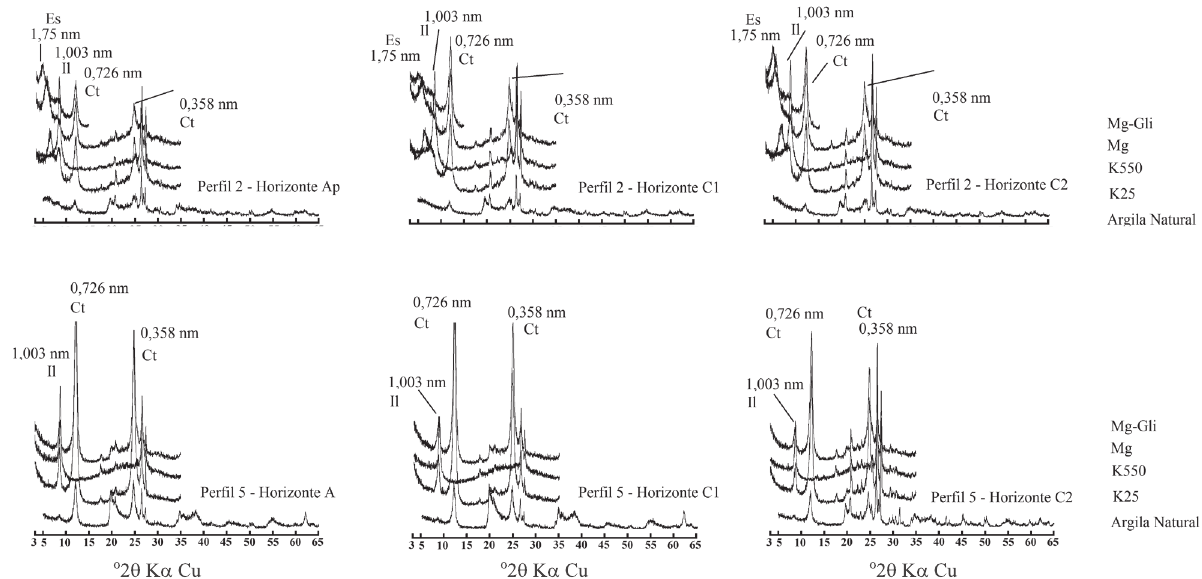
Figura 2. drX da fração argila do perfil 2 (horizontes: ap, C1 e C2) e do perfil 5 (horizontes: a, C1 e C2). o perfil 5 é representativo para os perfis 1, 3 e 4. es: mineral esmectítico (montmorilonita, beidelita, nontronita); il: ilita; Ct: